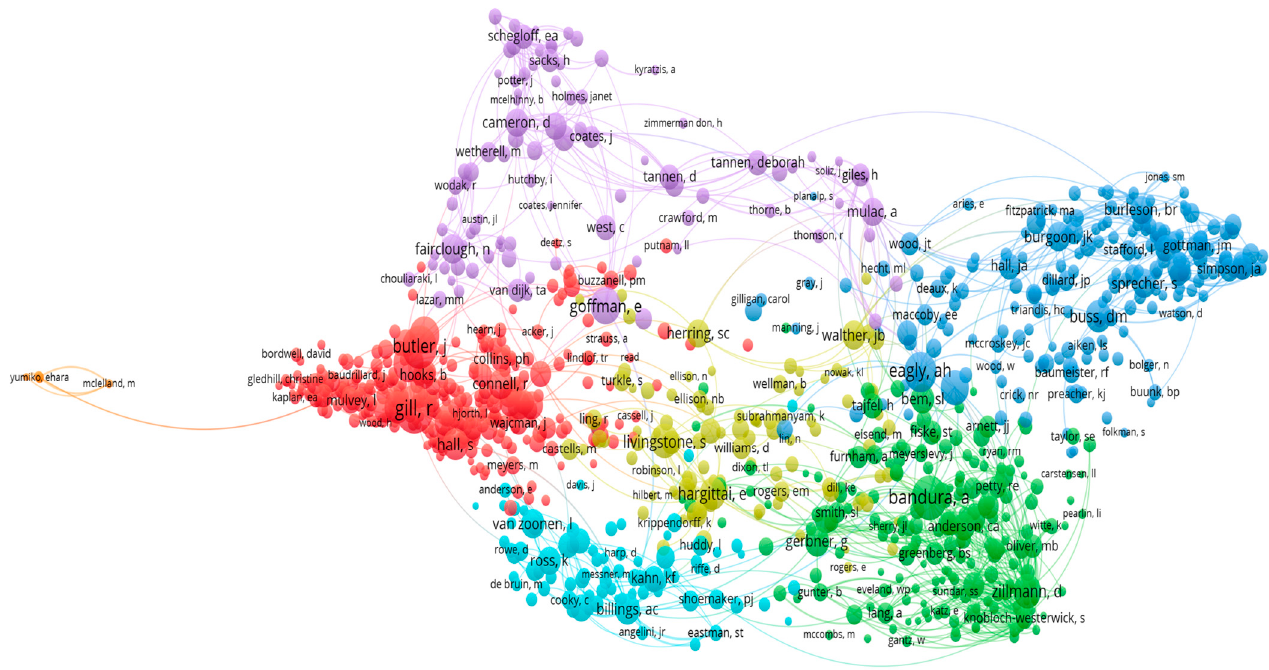
Figure 2. Network visualization of co-citation with weights based on co-citation. Table 5. Overview of distribution in seven clusters of top 50 authors based on co-citations.